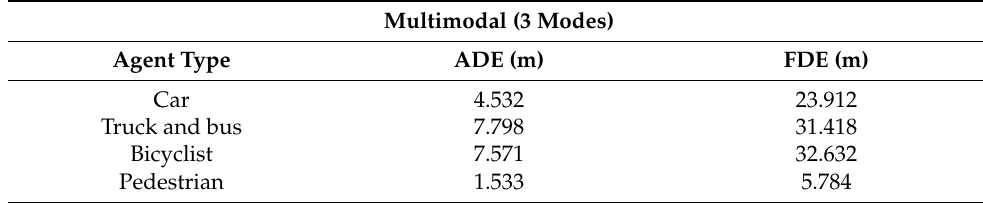
Table 4. Multimodal results for different agent types.